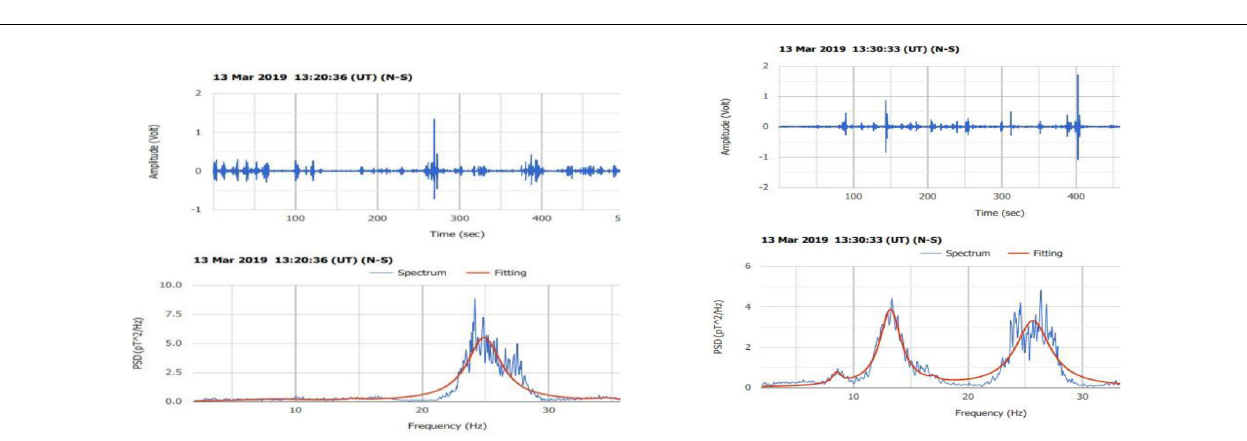
FIGURE 8 | Possible preseismic signal (left) and signal due to shooting by a two-barrel hunting rifle (right) .